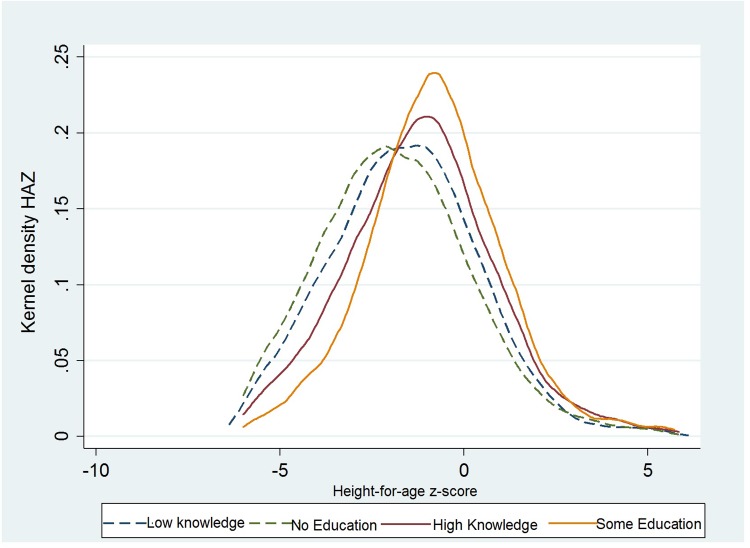
Kernel density plots of the distribution of child’s HAZ scores by mother’s knowledge and mother’s education.